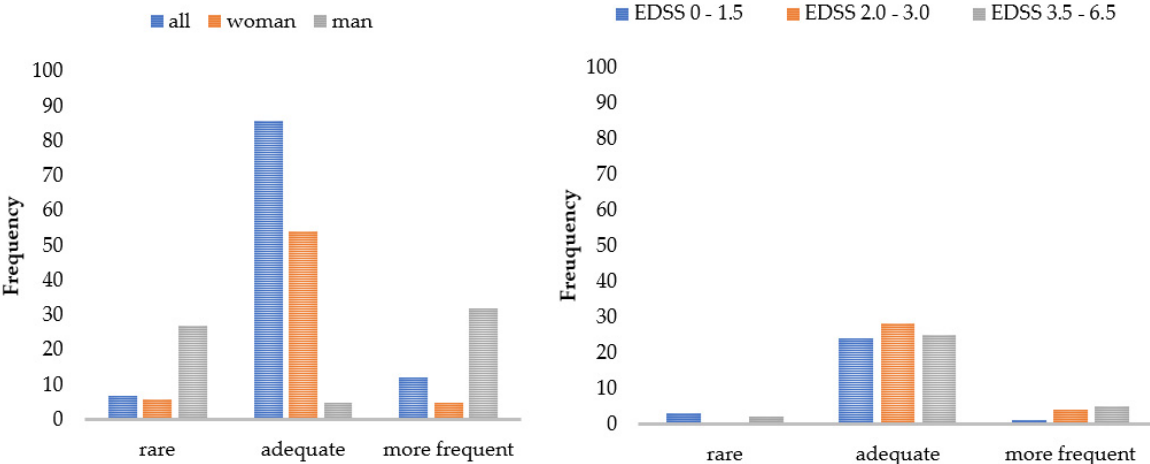
Figure 4. Patient ratings of the implementation frequency by subgroups. Number of patients who would like to receive the walking assessment less/more often or as currently applied. EDSS = Expanded Disability Status Scale.